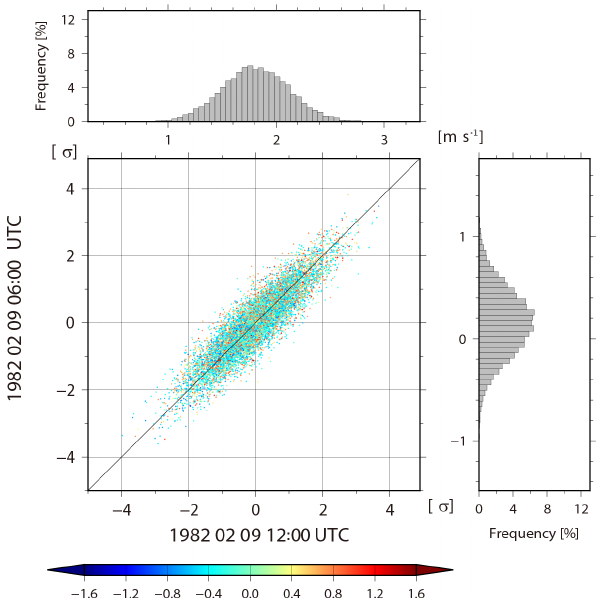
Figure 13. Similar to Fig. 11, but for 06:00UTC versus 12:00UTC on 9 February for background zonal wind at the fourth model level ( ∼ 500hPa).